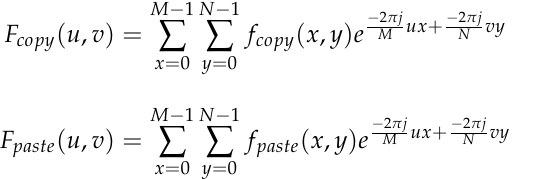
Figure 5. Flow chart of build-building. Among them, the red box area is the low frequency area.